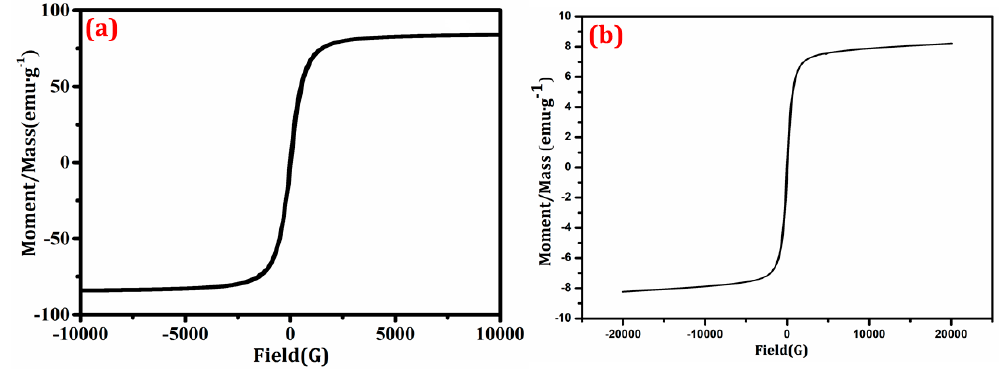
Figure 6. Hysteresis loops of products ( a ) Mn 1-x Zn x Fe 2 O 4 ; ( b ) BiVO 4 /Mn 1-x Zn x Fe 2 O 4 /RGO.